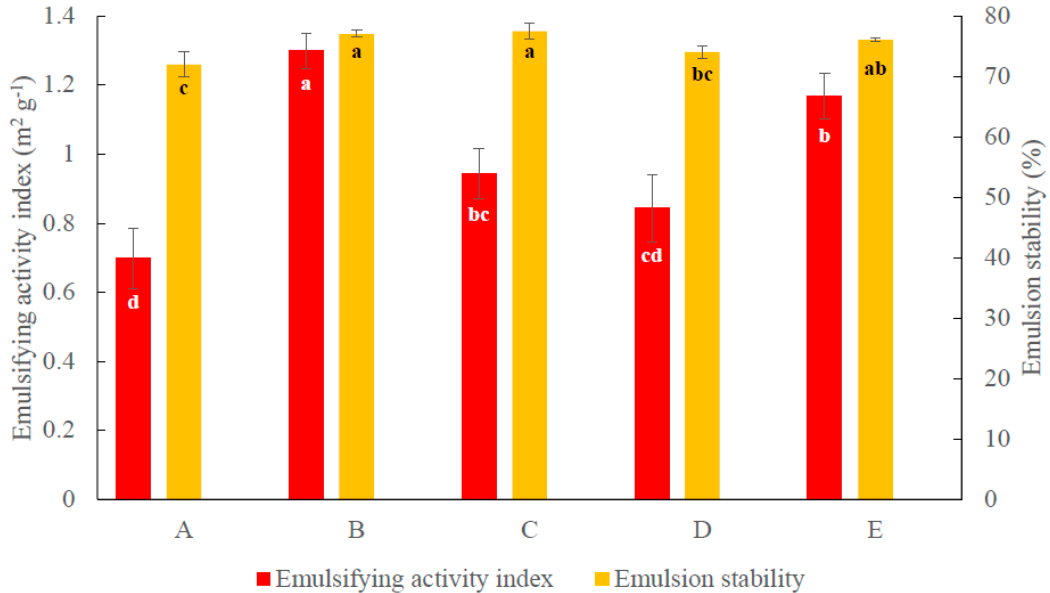
Figure 1. Emulsifying activity index and emulsion stability of aquafaba using different cooking conditions. A: Soaking seed in 4 ◦ C water for 16 h then cooking for 20 min; B: soaking seed in 4 ◦ C water for 16 h then cooking for 30 min; C: soaking seed in 4 ◦ C water for 16 h and cooking for 60 min; D: soaking seed in 85 ◦ C water for 1 h and cooking for 30 min; and E: soaking seed in 85 ◦ C water with 0.2% ( w / w ) NaHCO 3 for 1 h and cooking for 20 min. Different letters (a–d) refer to significant differences among different aquafaba production conditions according to Tukey’s test ( p < 0.05).